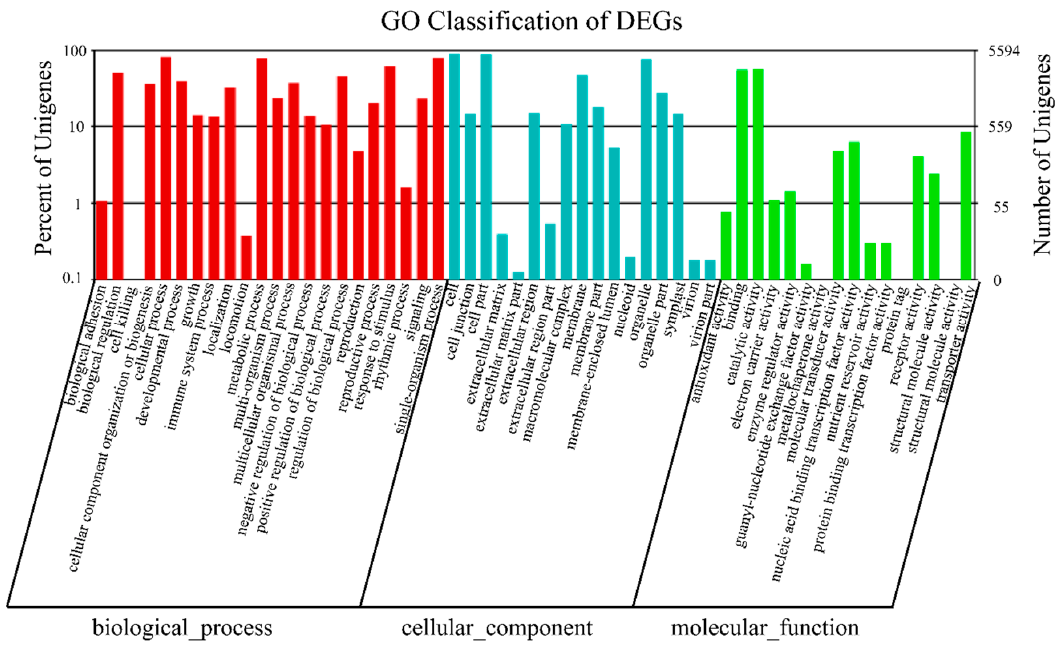
Figure 2. GO analysis of differentially expressed genes (DEGs) based on biological process, cellular component and molecular function categories.